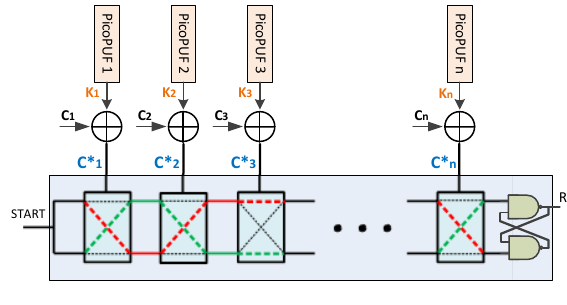
Figure 3. The XMPUF design with challenges